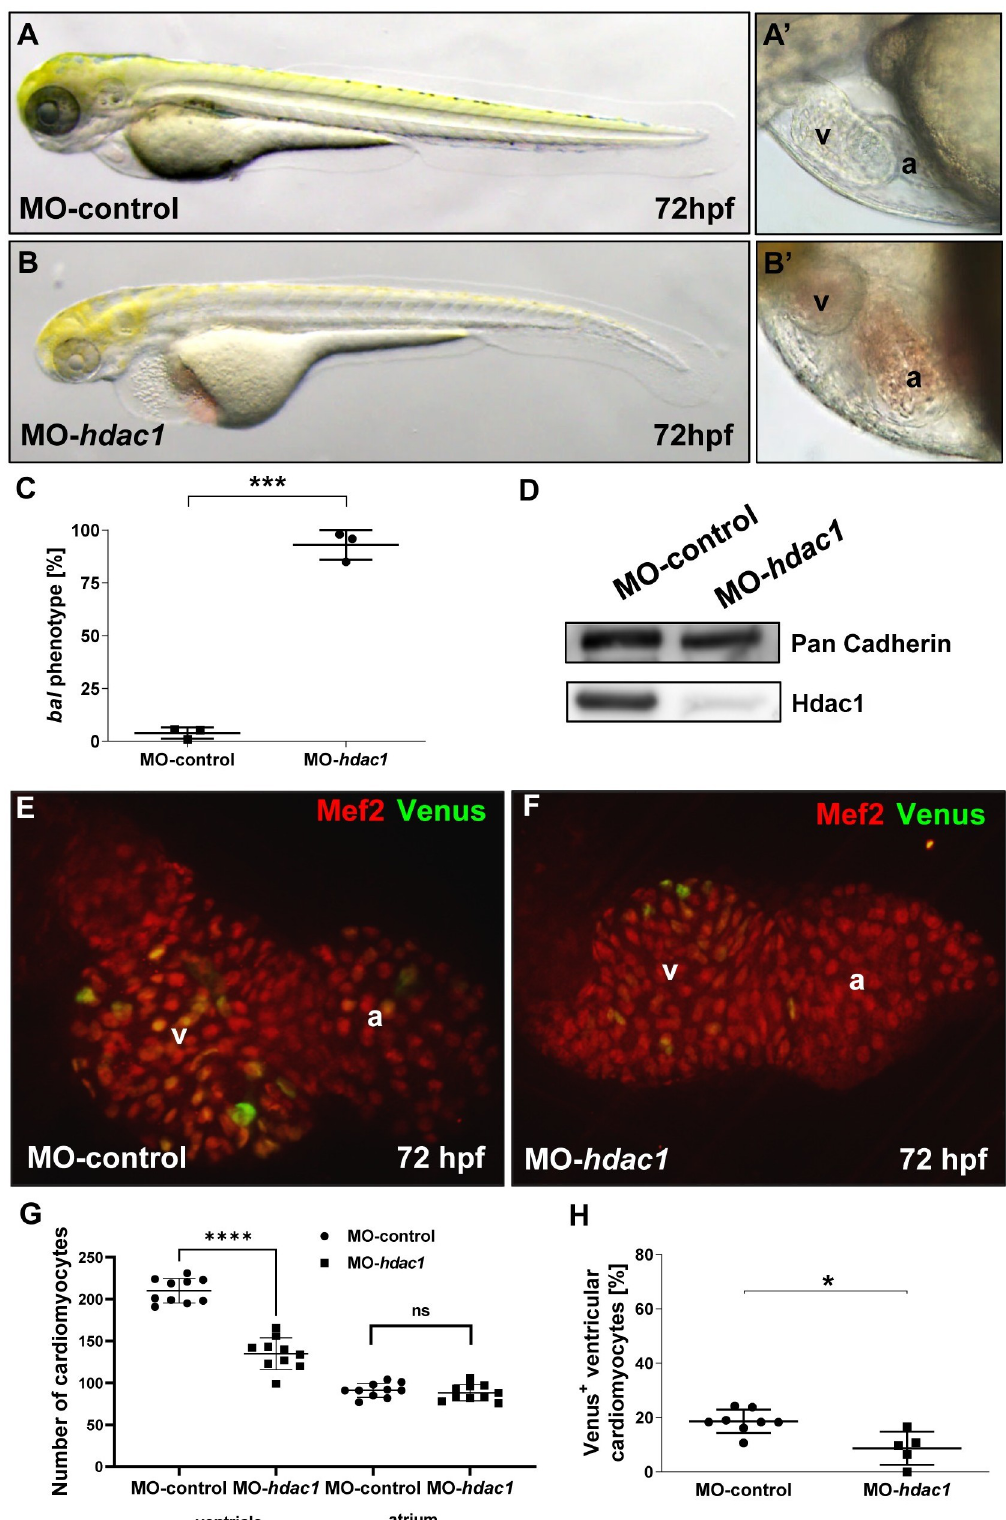
Fig 4. Morpholino-mediated knockdown of hdac1 phenocopies bal mutants. (A-B’) Lateral view of MO-control (A, A’) and MO- hdac1 (B, B’) at 72 hpf, injection of MO- hdac1 led to the bal heart phenotype (B’). (C) Statistical analysis of MO-